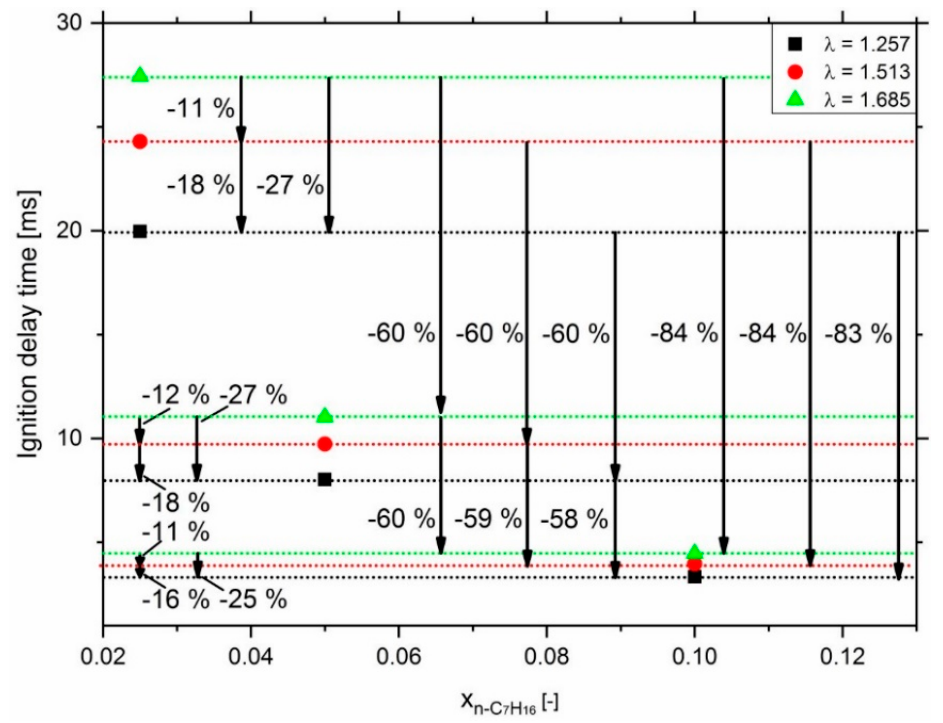
Figure 15. IDT of a gas mixture consisting of 95 mol % CH 4 , 5 mol % C 3 H 8 , and various amounts of n-C 7 H 16 , simulated at 770 K, 60 bar and air-fuel ratios of 1.257, 1.513 and 1.685 using the mechanism of Mehl et al.